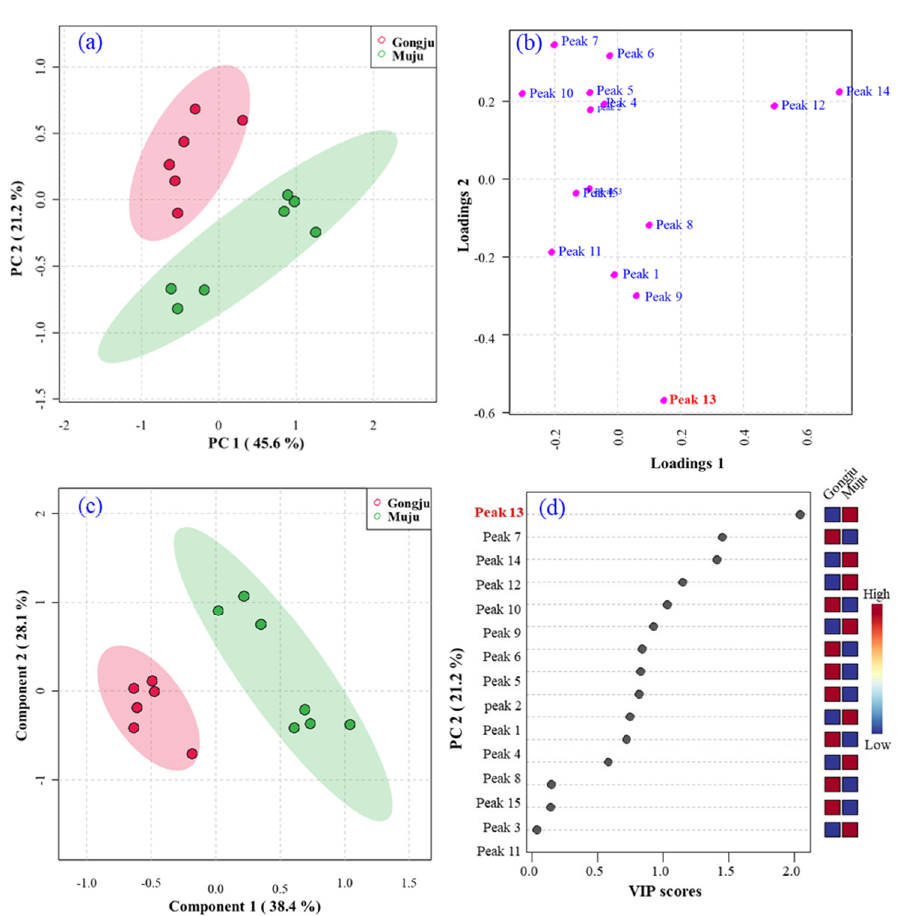
Figure 5. ( a ) Unsupervised PCA score plot, ( b ) loading plot, ( c ) supervised PLS-DA score plot and ( d ) VIP score plot based on the HPLC fingerprints of A. quinata leaves from Gongju and Muju.